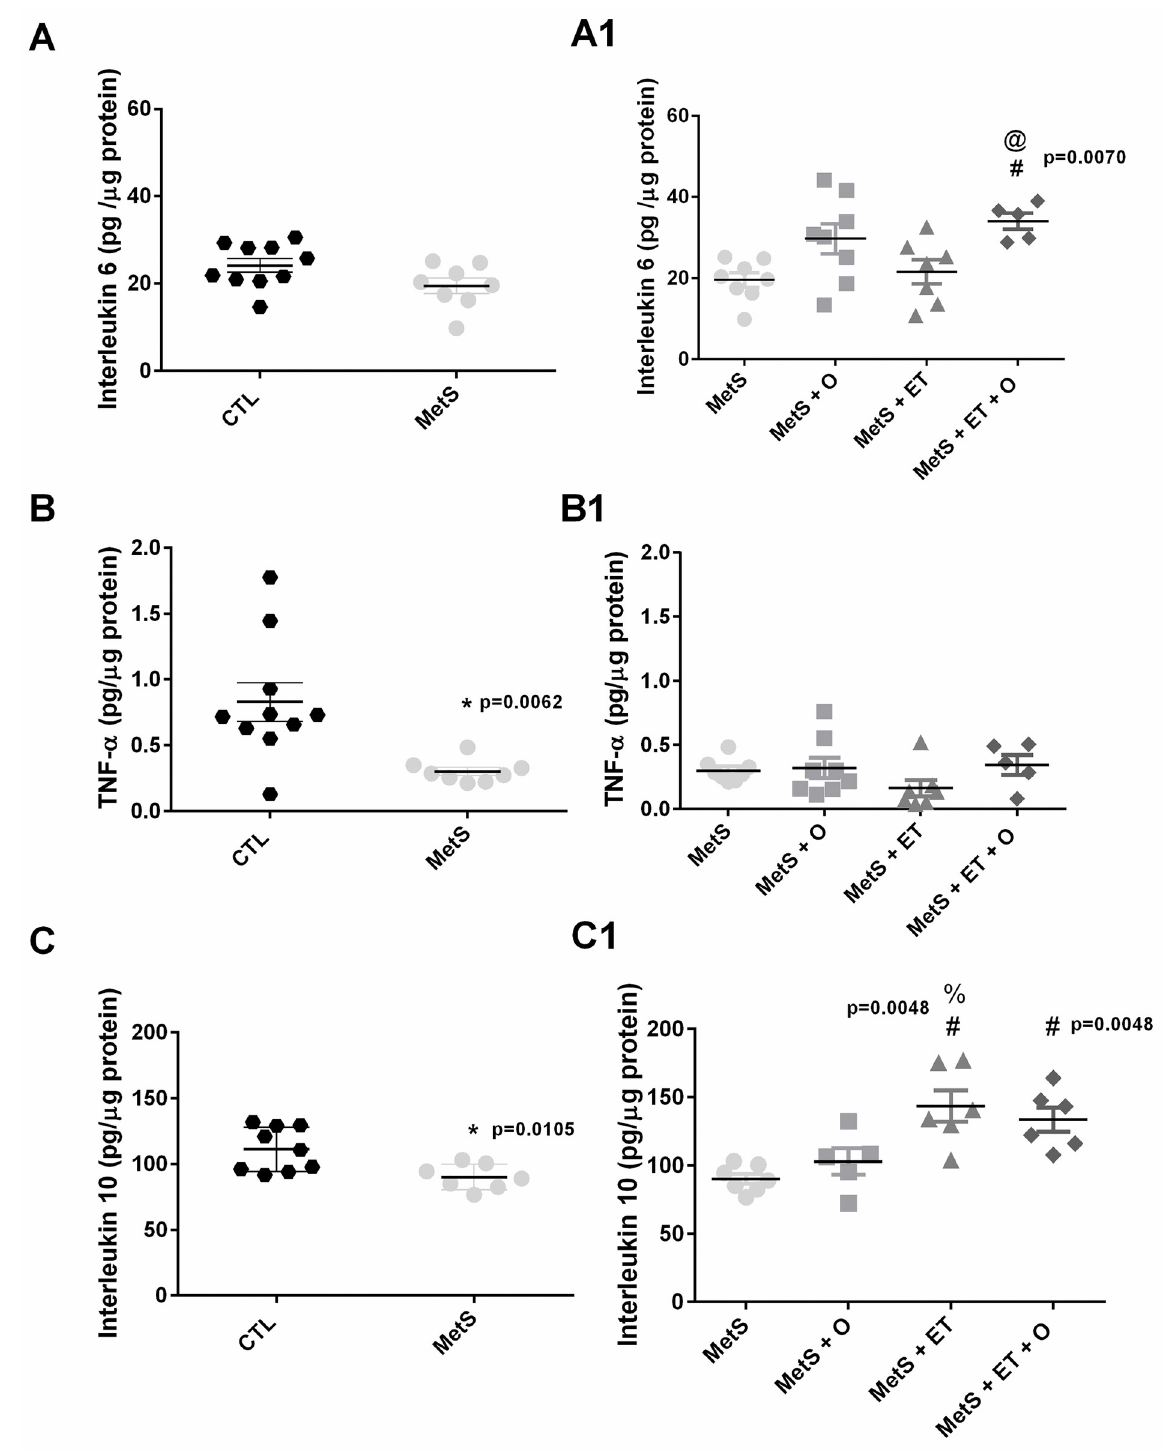
Fig 5. Analysis of inflammatory cytokines in renal tissue. (A/A1) Interleukin 6 (p = 0.0070), (B/B1) TNF- α (p = 0.0062), (C/C1) Interleukin 10 (p = 0.0048). � vs CTL, #vs. MetS, %vs. MetS + O, @vs. MetS + ET. Statistic: One-Way ANOVA, p < 0.05.